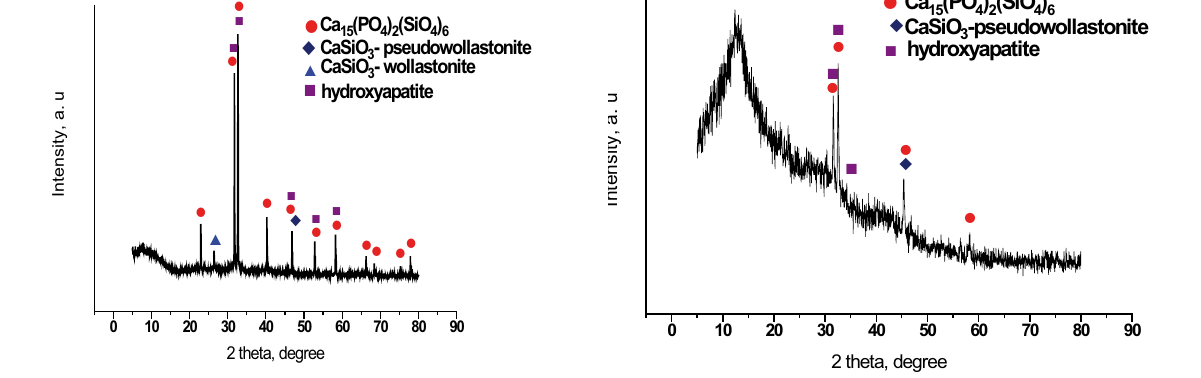
Figure 5. XRD of C-CPS/W (25:75 wt.%) after immersion in 1.5 SBF Figure 6. XRD of C-CPS/W (75:25 wt.%) after immersion in 1.5 SBF